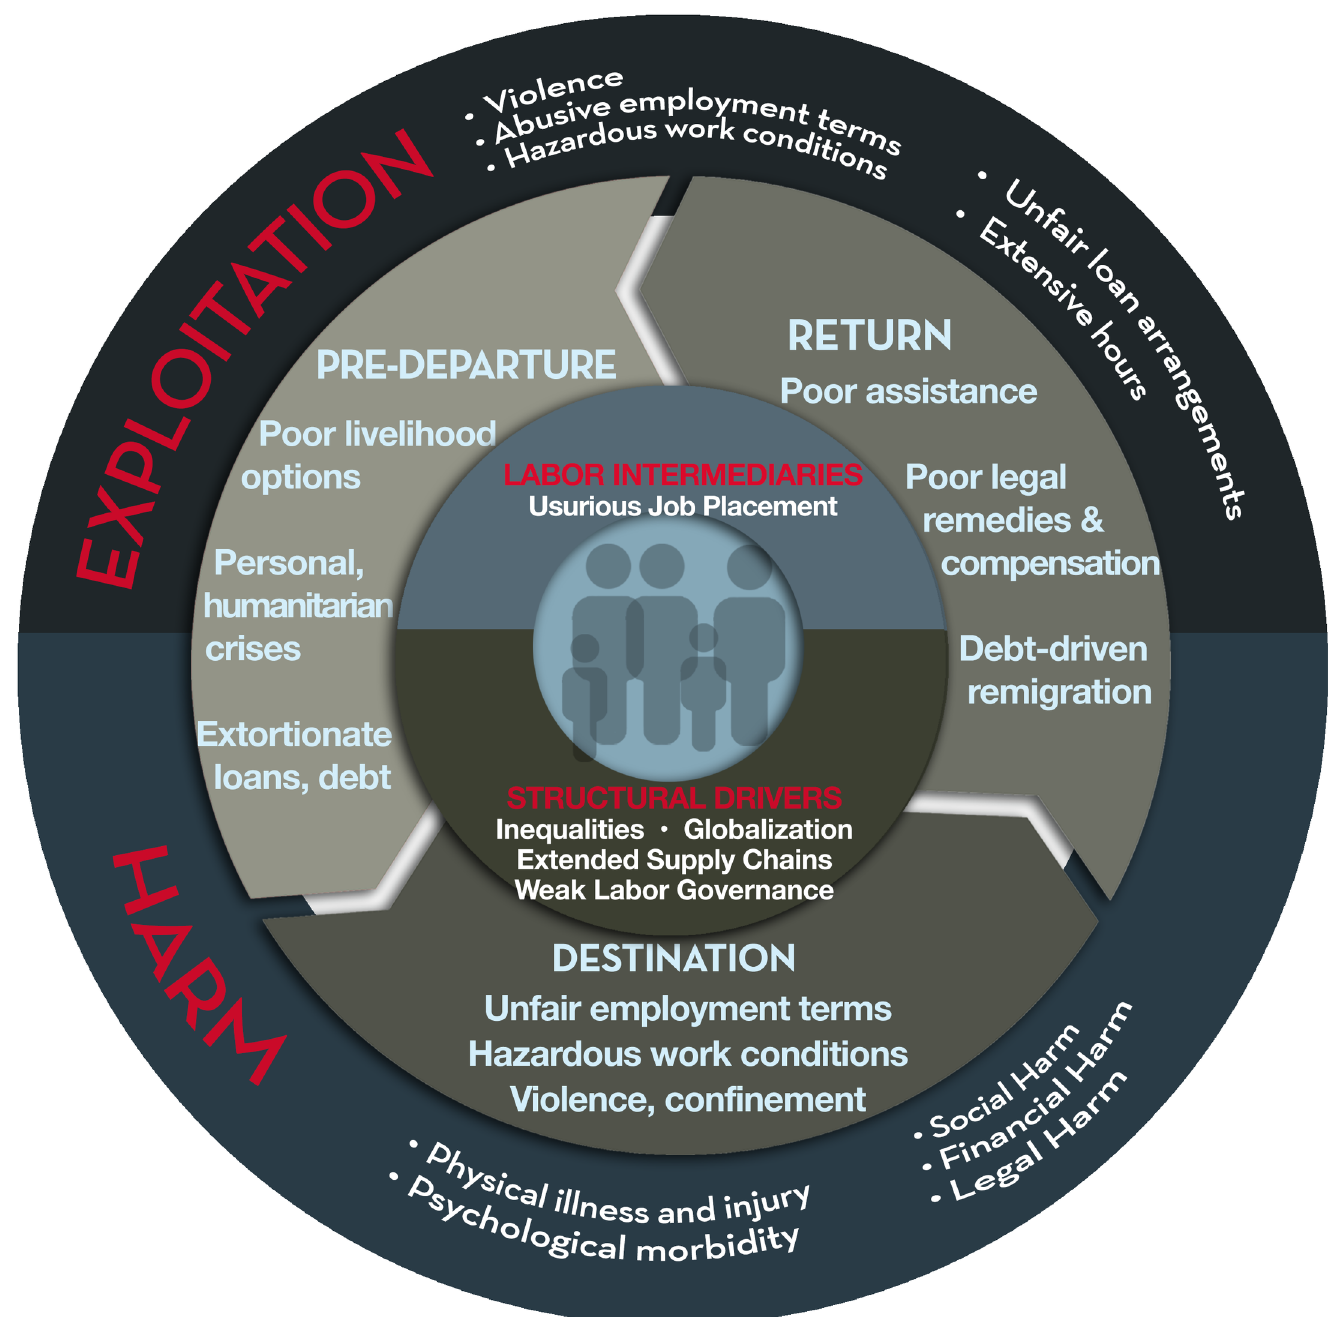
Fig 2. Socioeconomic determinants of labor exploitation and